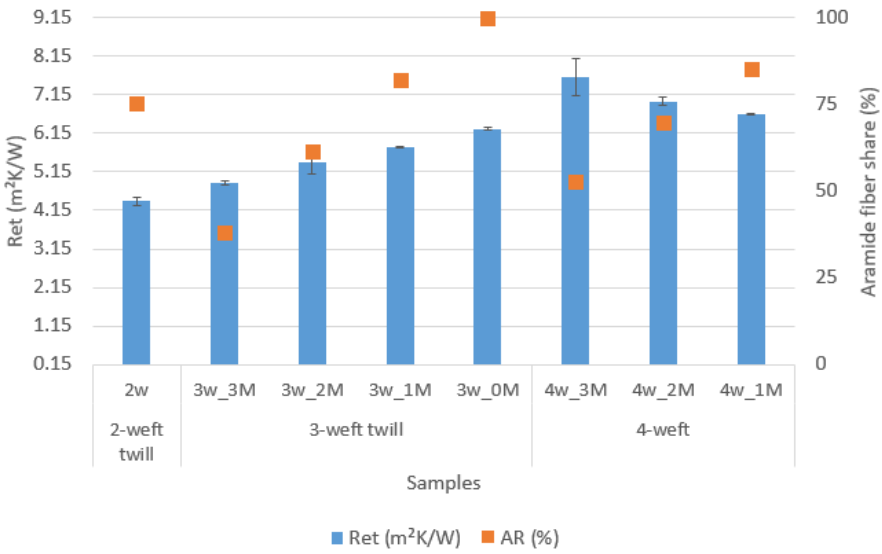
Figure 9. Correlation between Ret and aramid fiber content in fabric.